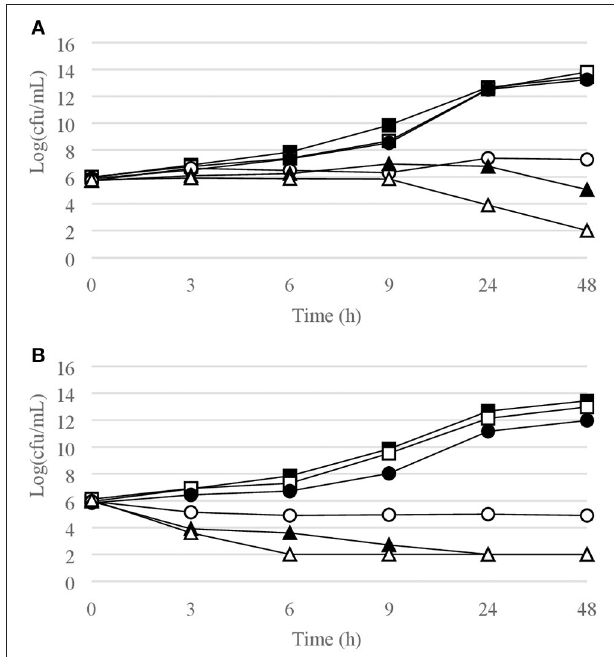
FIGURE 5 | Time-kill curves for P. aeruginosa . (A) chlorquinaldol; (B) gentamicin. Filled square, control; open square, ¼ × MIC; filled circle, ½ × MIC; open circle, 1 × MIC; filled triangle, 2 × MIC; open triangle, 4 ×